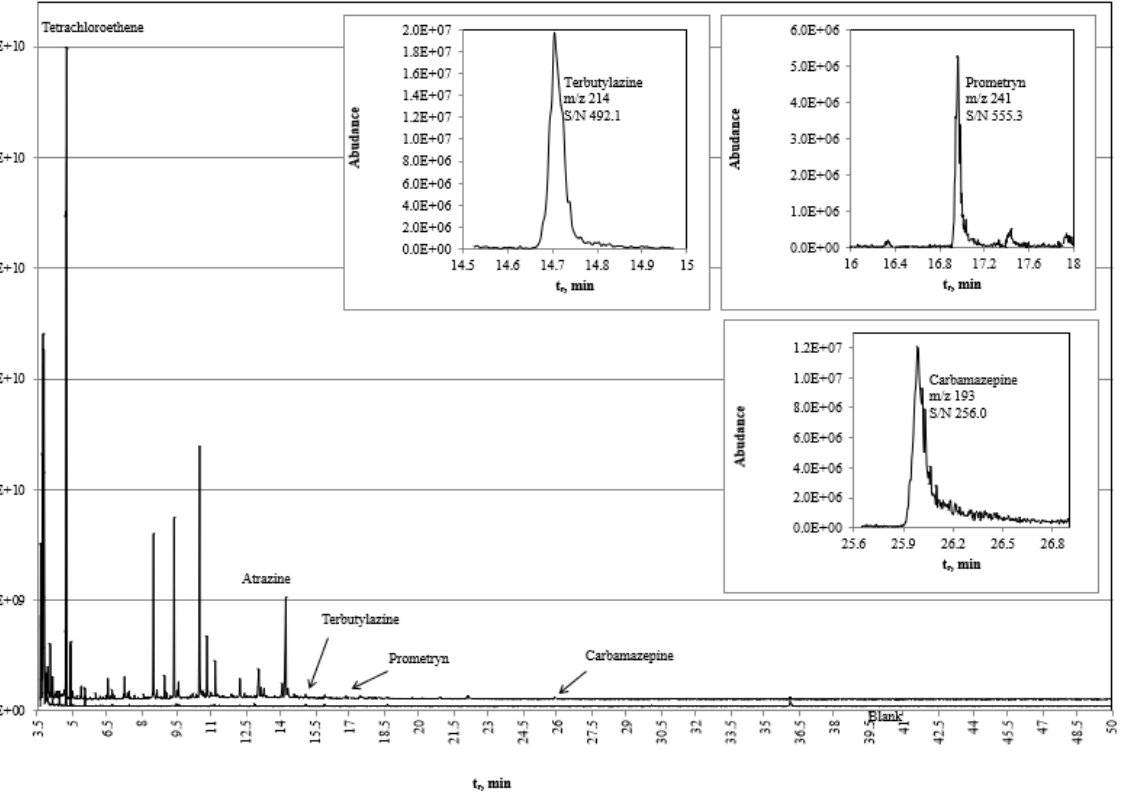
Figure 3. Comparison of elution efficiency of QC4 from ACFs using the two different methods (DCM (below) and DCM with 5% MeOH (above)).